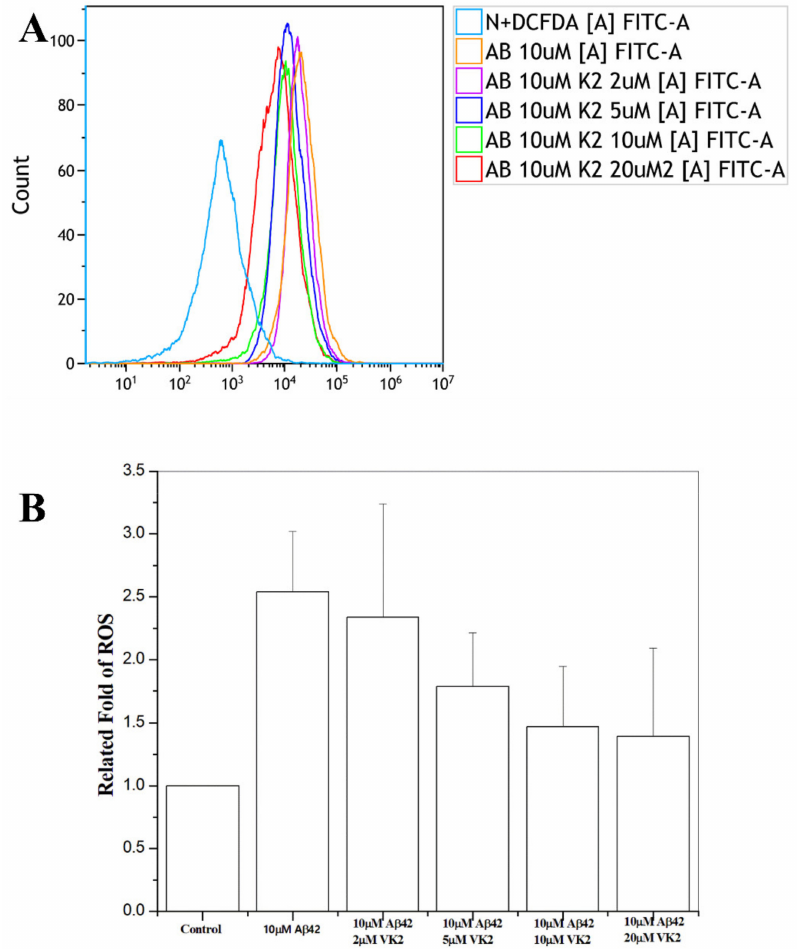
Figure 2. Production of reactive oxygen species (ROS) by cells. Flow cytometry of ROS production of β -CTF/C6 cells treated with ( A ) 10 µ M A β 42 and 0–20 µ M of vitamin K2 (VK2) doses at 60 h. ( B ) The related statistic fold for the ROS